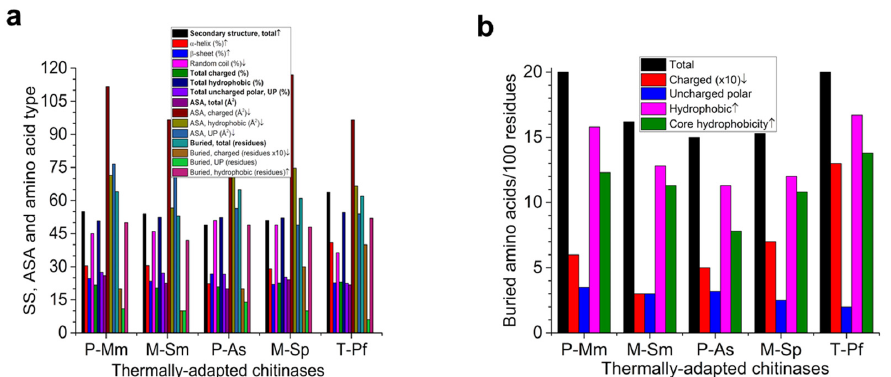
Figure 2. Compositional and structural features in thermally adapted chitinases. ( a ) Secondary structure (SS) elements, accessible solvent area (ASA), types of amino acids, and total buried residues. ( b ) Various types of buried amino acids normalized to per 100 residues. SS elements were found using X-ray structures; total charged (DEHKR), hydrophobic (GAVLIPMFW), and uncharged polar (CNQSTY) components were found using ProtParam; average ASA and various types of buried residues were found using WHATIF. ↑ , higher value of the parameter is associated with higher stability; ↓ , higher value of the parameter is associated with lower stability. P, psychrophilic; M, mesophilic; T, thermophilic. Mm, M. marina ; Sm, S. marcescens; As, Arthrobacter sp.; Sp, S. proteamaculans ; Pf, P. furiosus.